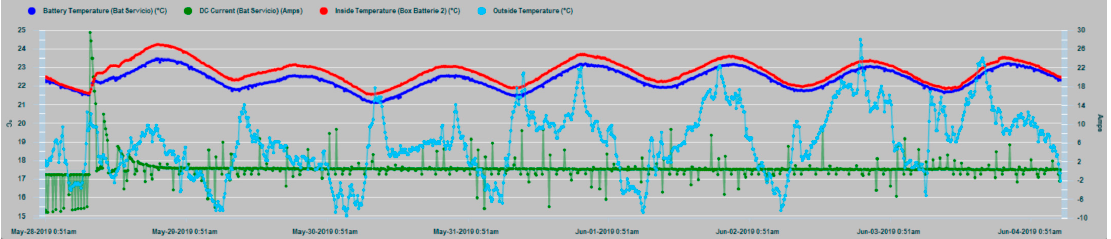
Figure 21. Peaks of energy demand versus temperature increases.